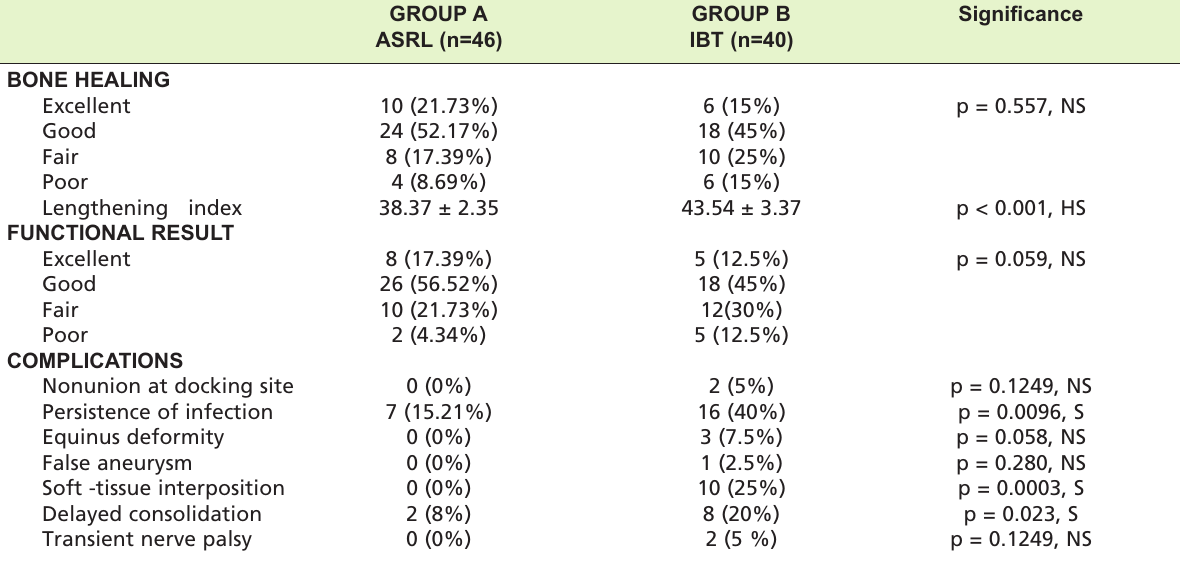
Evaluation of outcome in both groups Table IV: